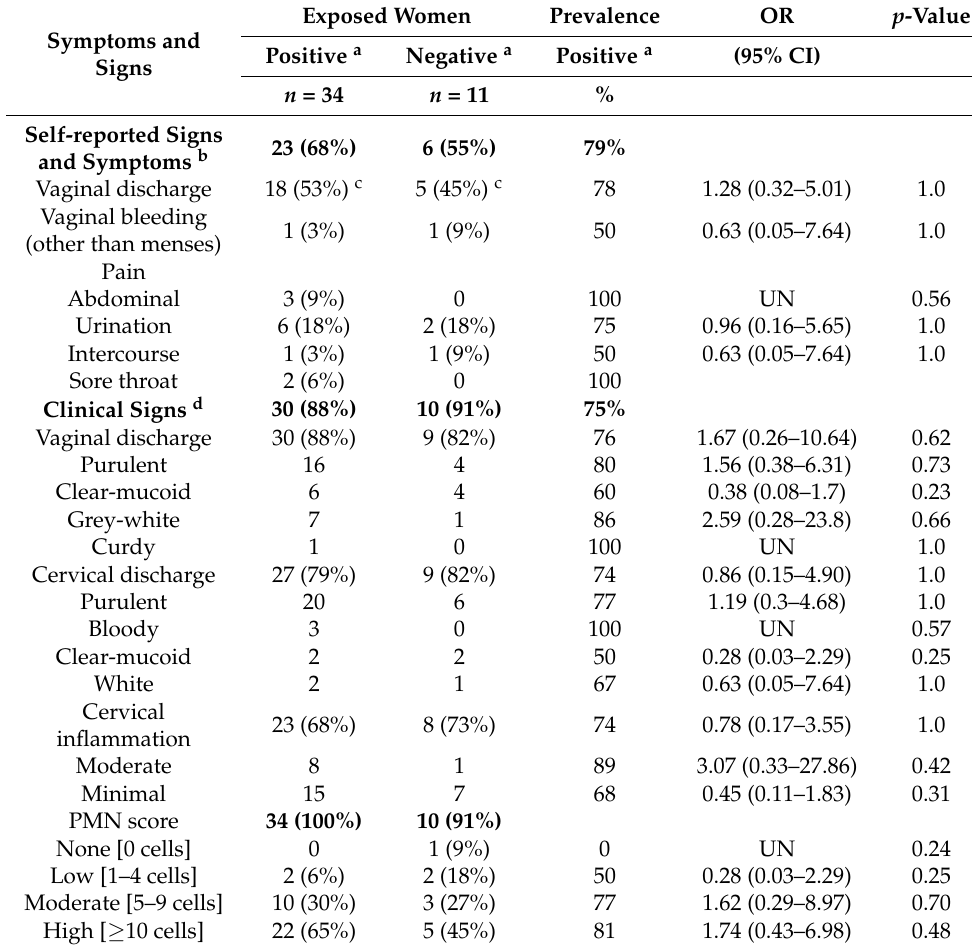
Table 4. Self-reported and diagnosed clinical symptoms, inflammation, and prevalence of Neisseria gonorrhoeae culture-positivity among exposed women. Exposed Women Prevalence Symptoms and Signs Self-reported